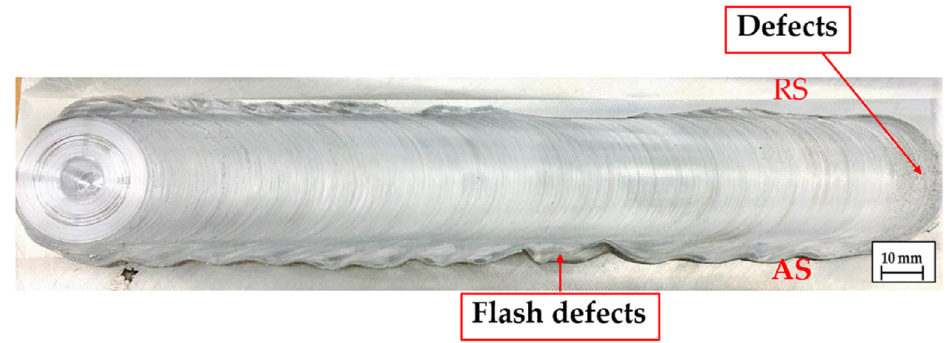
Figure 15. Welding characteristics of aluminum alloy SSM 5083 at the optimal conditions for tensile strength (a rotational speed of 1200 rpm, a welding speed of 10 mm/min, and with a threaded cylindrical tool pin profile).